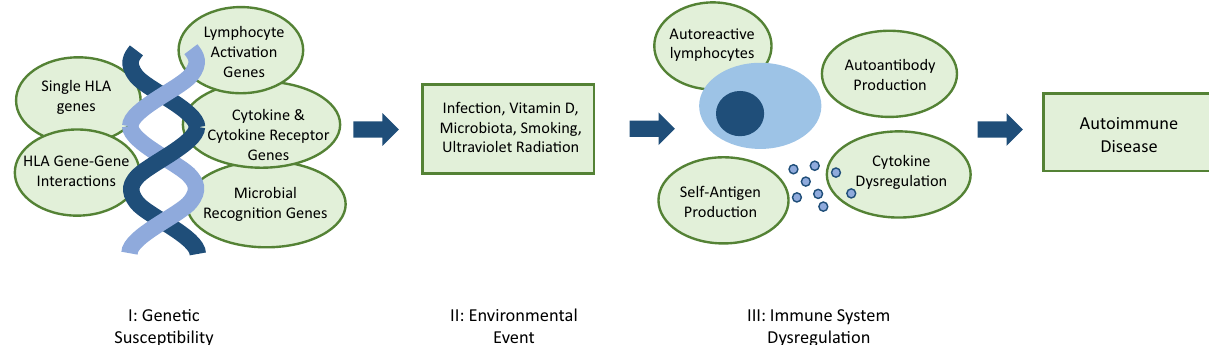
Fig. 1 The three factors contributing to autoimmune disease development. I genetic susceptibility is conferred by a combination of genes that may include genes encoding human leukocyte antigen (HLA) innate and adaptive immune proteins, and directly or indirectly affect the regulation of the immune system. II examples of potential environmental triggers for dysregulation. III autoantibody production alone will not always result in disease development; self-antigen production and subsequent elevated immune response is necessary. 3